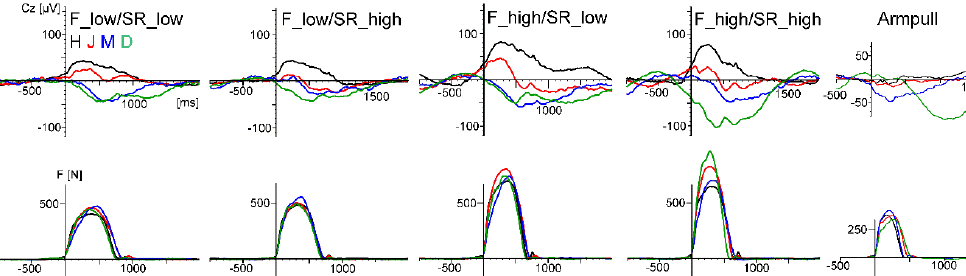
Figure 9. The upper row displays the force-onset triggered individual averages (subjects D, M, J,